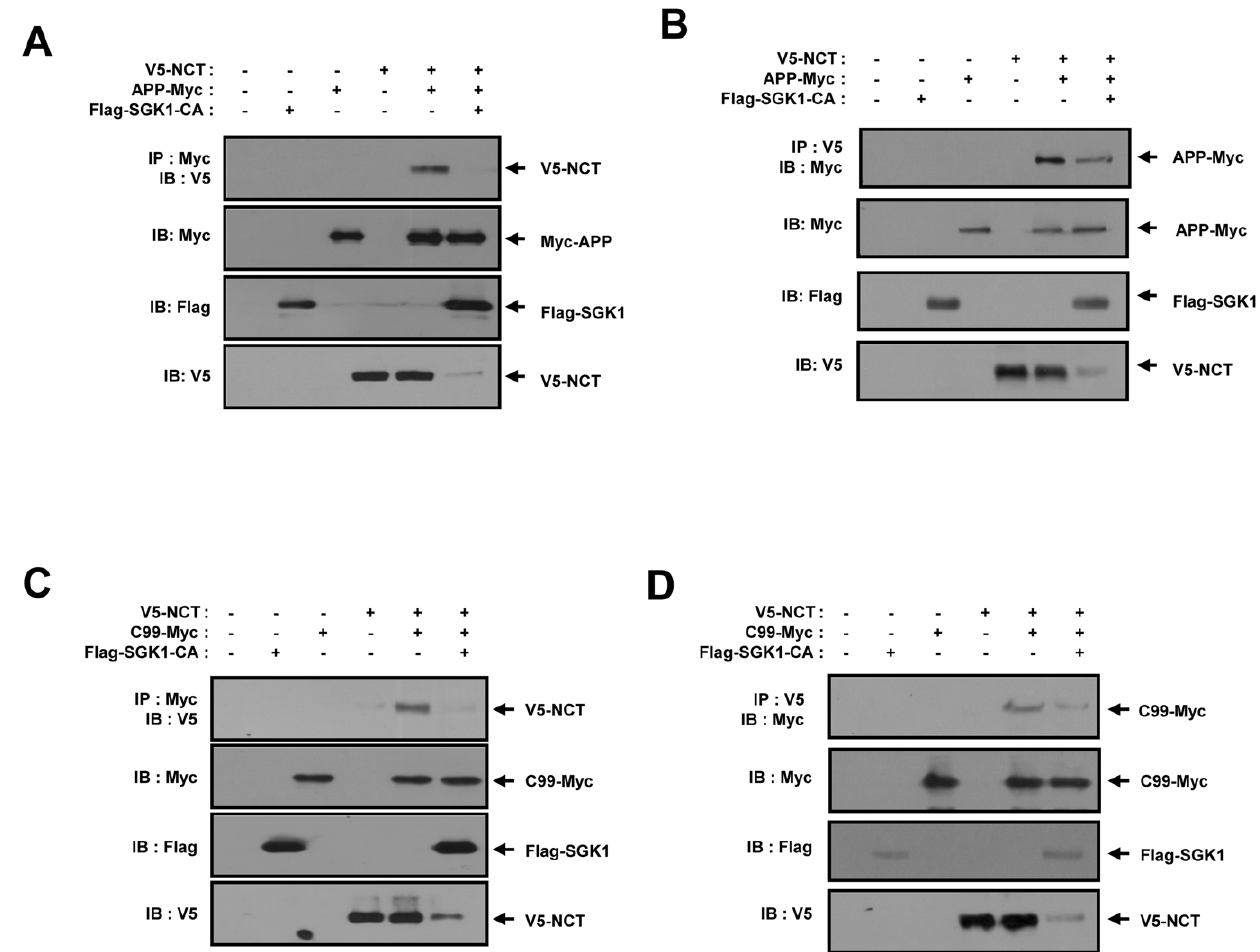
Figure 2. SGK1 prevents the physical interaction between NCT and APP. (A, B) HEK293 cells were transfected for 48 hours with expression vectors encoding for the indicated combinations of 2 m g of V5-NCT, 2 m g of APP-Myc, and 6 m g of Flag-SGK1- CA. (A) Cell lysates were subjected to immunoprecipitation with an anti-Myc antibody (9E10), and the immunoprecipitates were immunoblotted with an anti-V5 antibody. (B) Cell lysates were subjected to immunoprecipitation with an anti-V5 antibody, and the immunoprecipitates were immunoblotted with an anti-Myc antibody (9E10). (C, D) HEK293 cells were transfected for 48 hours with expression vectors encoding for the indicated combinations of 2 m g of V5-NCT, 2 m g of C99-Myc, and 4 m g of Flag-SGK1-CA. (C) Cell lysates were subjected to immunoprecipitation with an anti-Myc antibody (9E10), and the immunoprecipitates were immunoblotted with an anti-V5 antibody. (D) Cell lysates were subjected to immunoprecipitation with an anti-V5 antibody, and the immunoprecipitates were immunoblotted with an anti-Myc antibody (9E10). (A–D) The cell lysates were also subjected to immunoblot analysis with anti-Myc (9E10), anti-Flag, and anti-V5 antibodies, respectively. These results represent one of three independent experiments. IB, Immunoblot. IP,